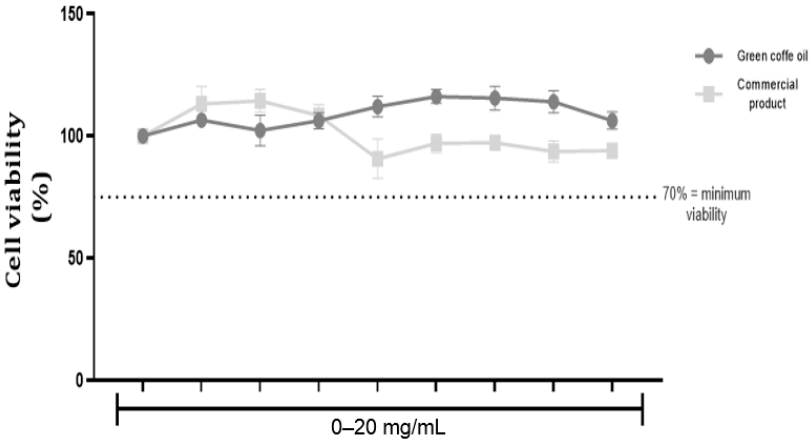
Figure 4. Cell viability of human keratinocytes after exposure to different concentrations of green coffee oil, for a period of 24 h. The assay was performed in triplicate.